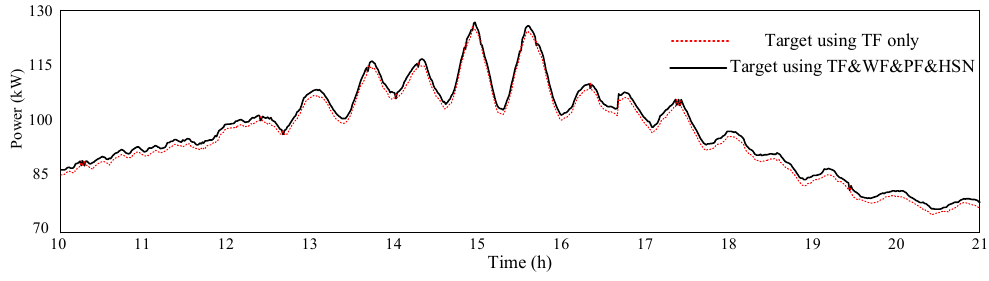
Figure 24. Parameters’ influence on optimizing target.